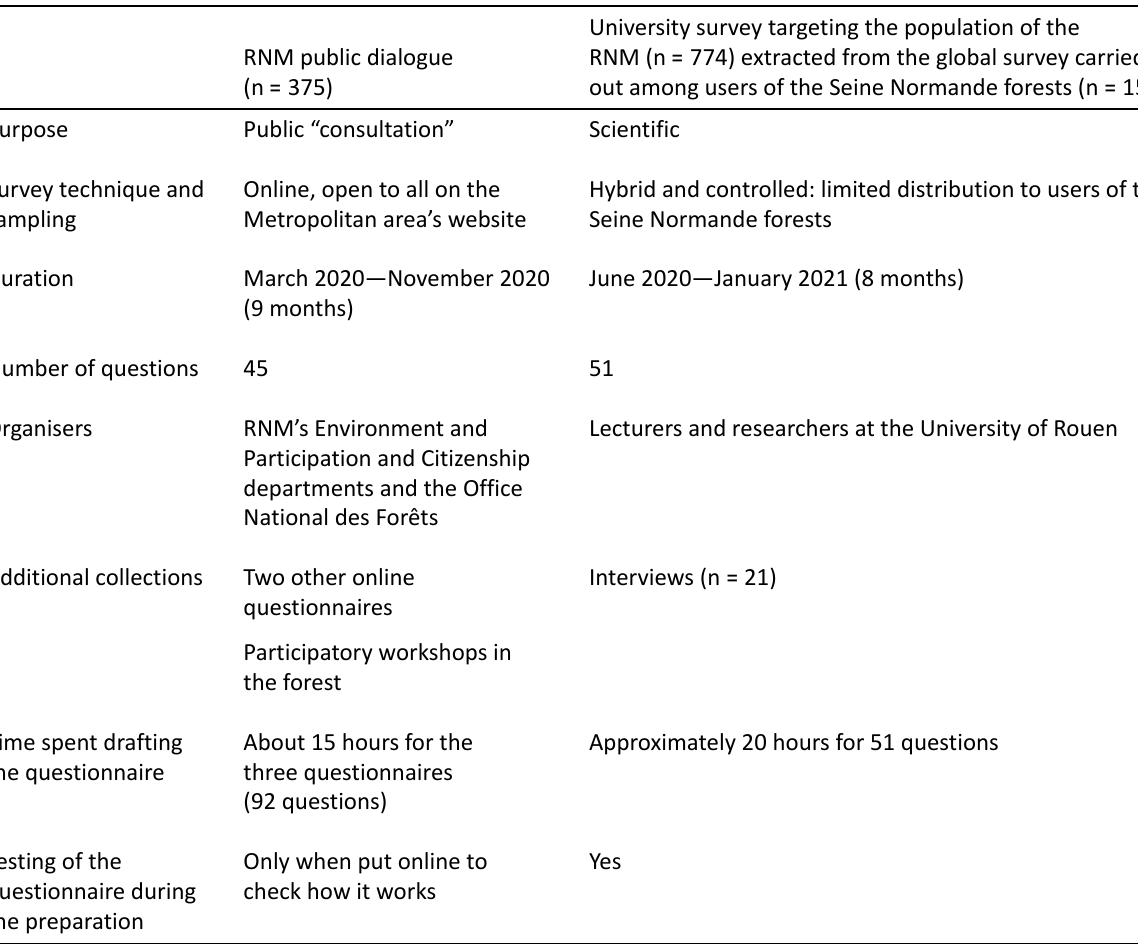
Table 1. Characteristics of the two